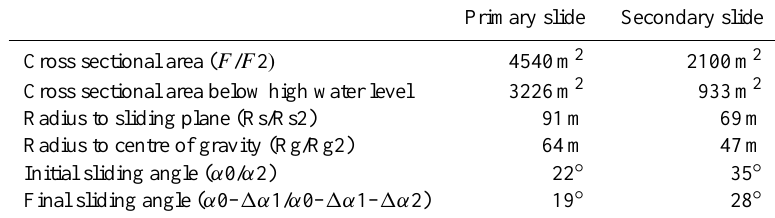
Table 2. Geometric parameters of the double slider block